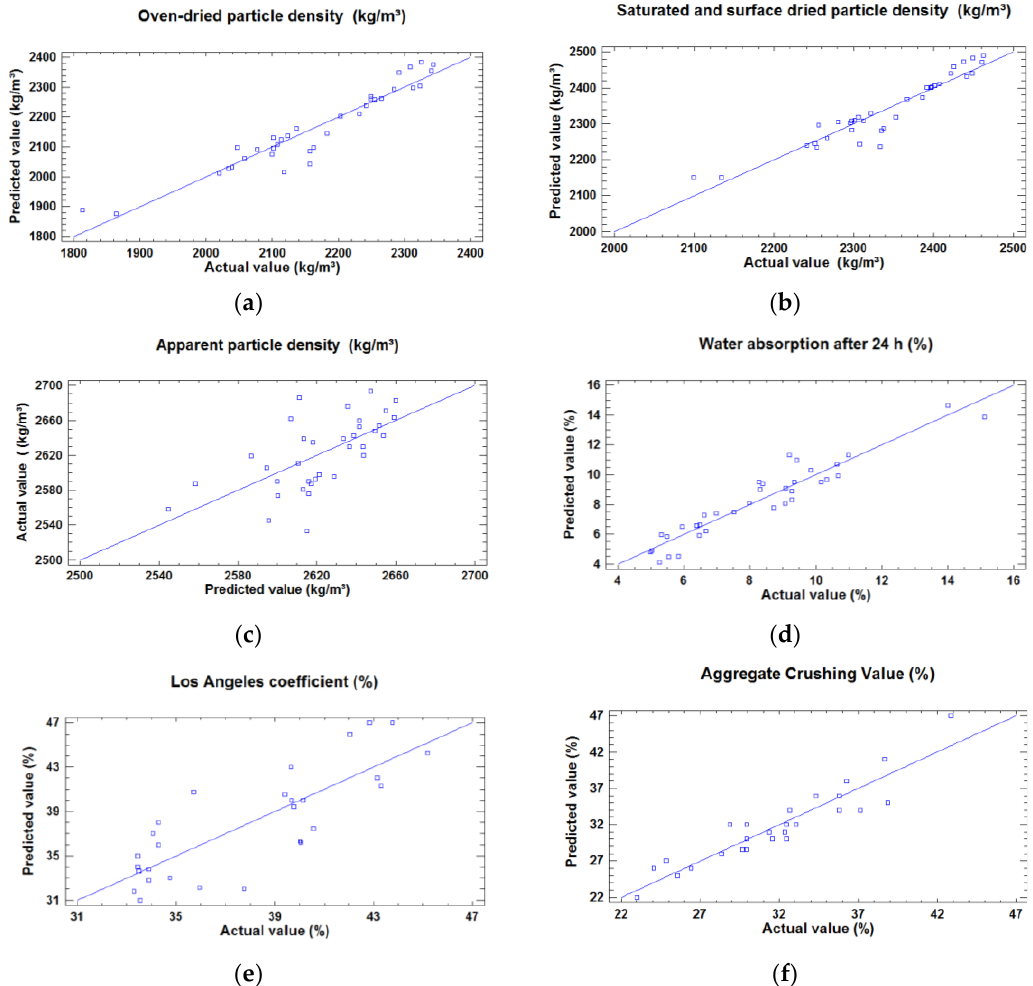
Figure 5. Comparison of the experimental values with the predicted values using the multiple linear regression: ( a ) oven-dried particle density, d rd ; ( b ) saturated and surface dried particle density, d SSD ; ( c ) apparent particle density, d a ; ( d ) water absorption after 24 h, WA; ( e ) Los Angeles coefficient, LA; and ( f ) Aggregate Crushing Value, ACV.